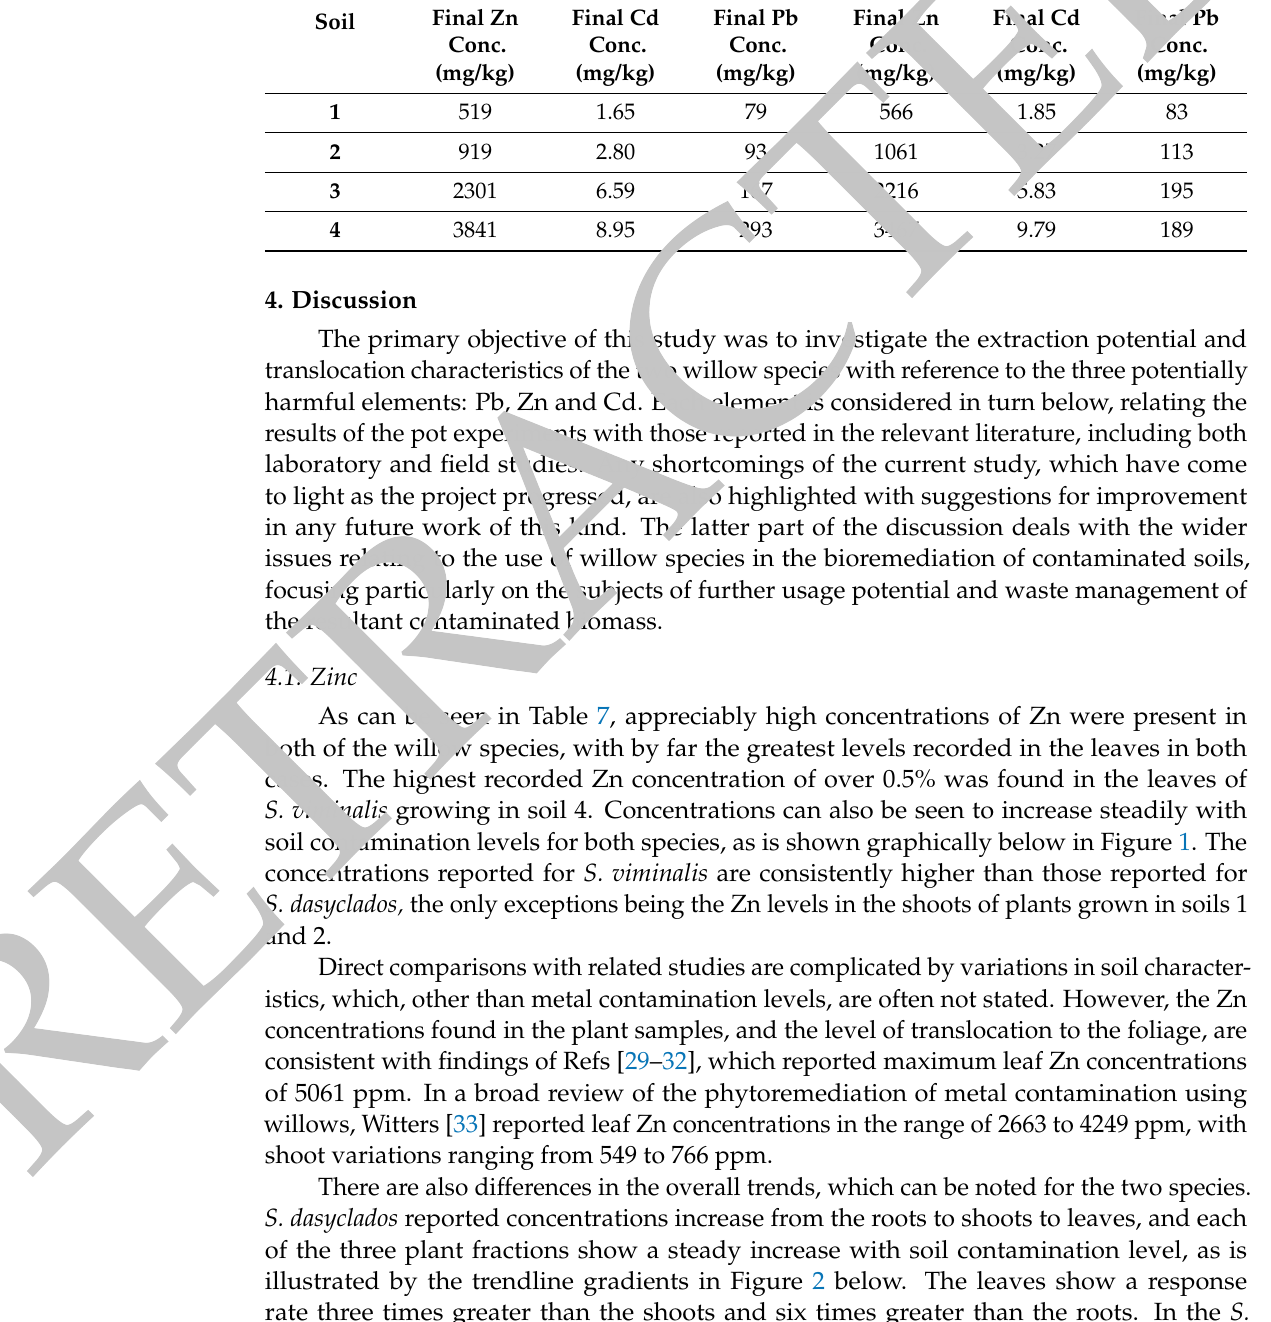
Table 9. Final soil concentrations of Zn, Cd and Pb. Separate values given for soils that were supporting each of the two willow species. S.